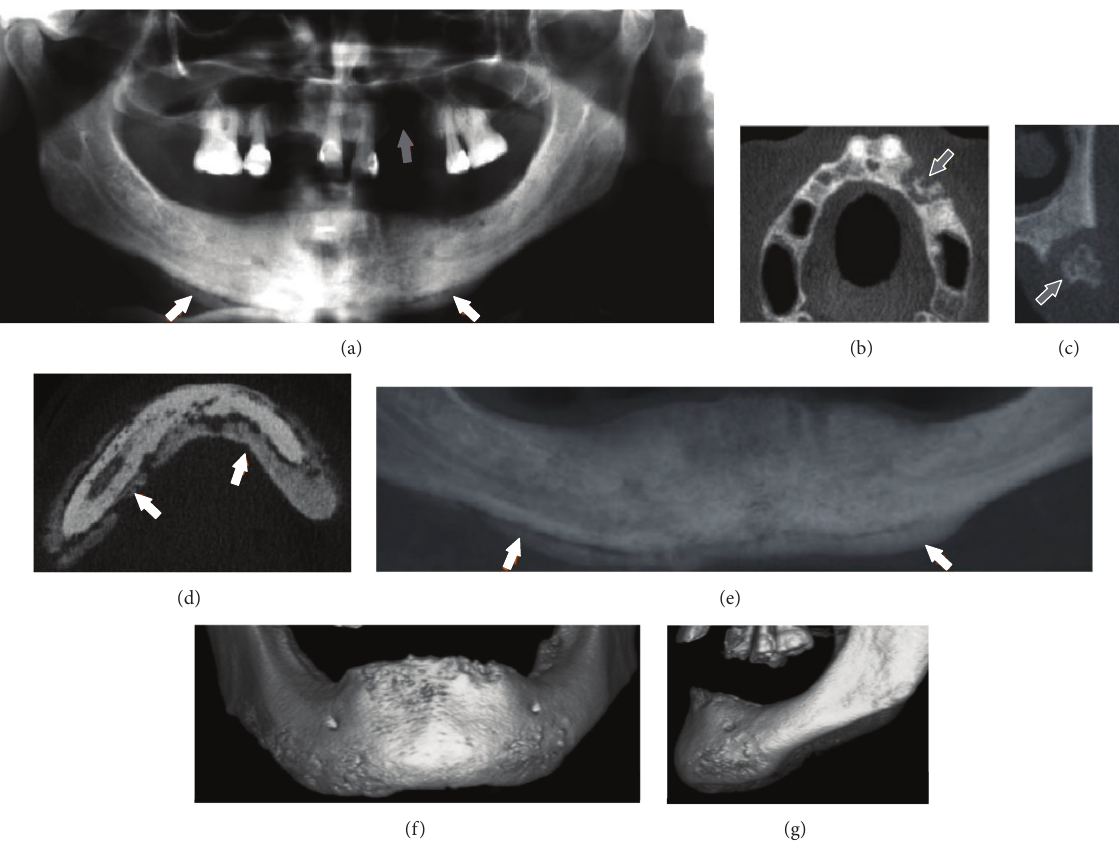
Figure 2: Imaging findings of a 57-year-old woman with metastatic breast carcinoma receiving intravenous zoledronic acid. (a) Panoramic radiograph showing maxillary involvement with radiographic evidence of osteolysis (gray arrow). (b) and (c) axial and cross-sectional CBCT views, respectively, showing the necrotic area with bone sequestrum in the left maxilla (gray arrow). (d) Axial CBCT image showing the extent of mandible bone involvement with periosteal bone reaction. The periosteal bone reaction changed the mandibular morphology, as it can be seen in the two-dimensional multiplanar reconstruction image ((e), white arrow) and in the 3D images (frontal view (f) and sagittal view